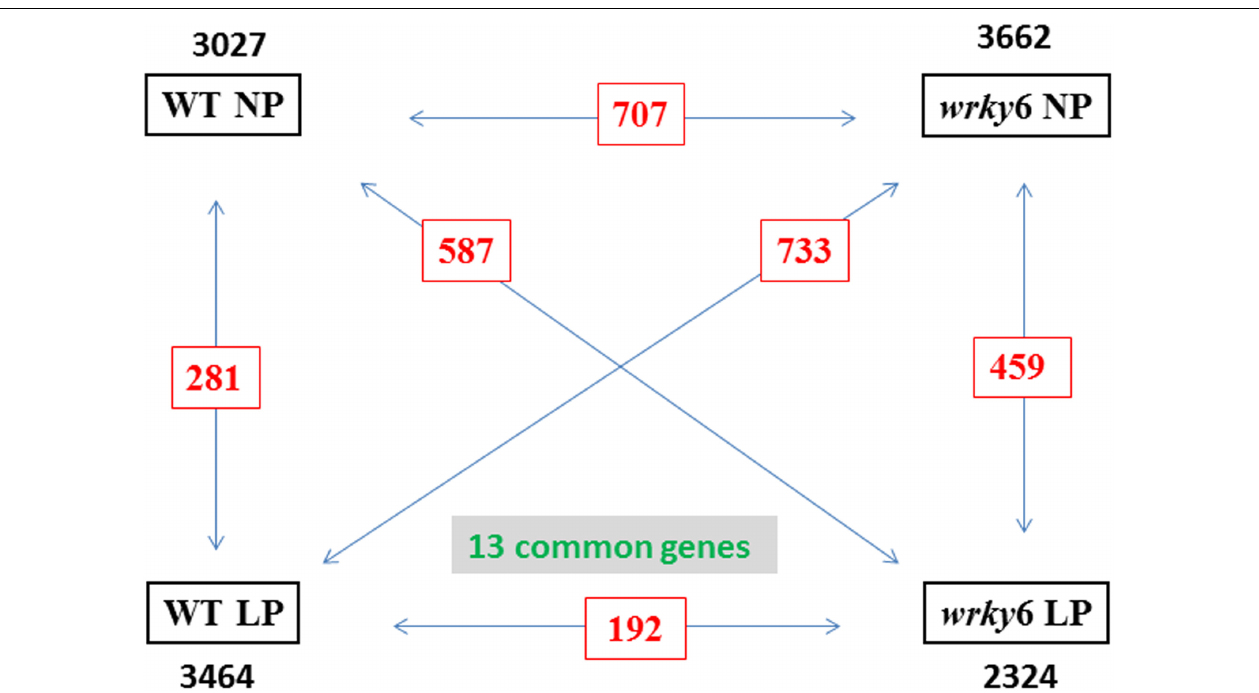
FIGURE 1 | Total number of differentially regulated genes which responded to Piriformospora indica in the roots of WT or wrky6 seedlings grown on either NP or LP. The black numbers show all genes regulated more than 2-fold in the roots of WT or wrky6 seedlings grown on either NP or LP media. Common genes among the two datasets are in red. Thirteen genes are common to all datasets. For specific genes, see data submitted to